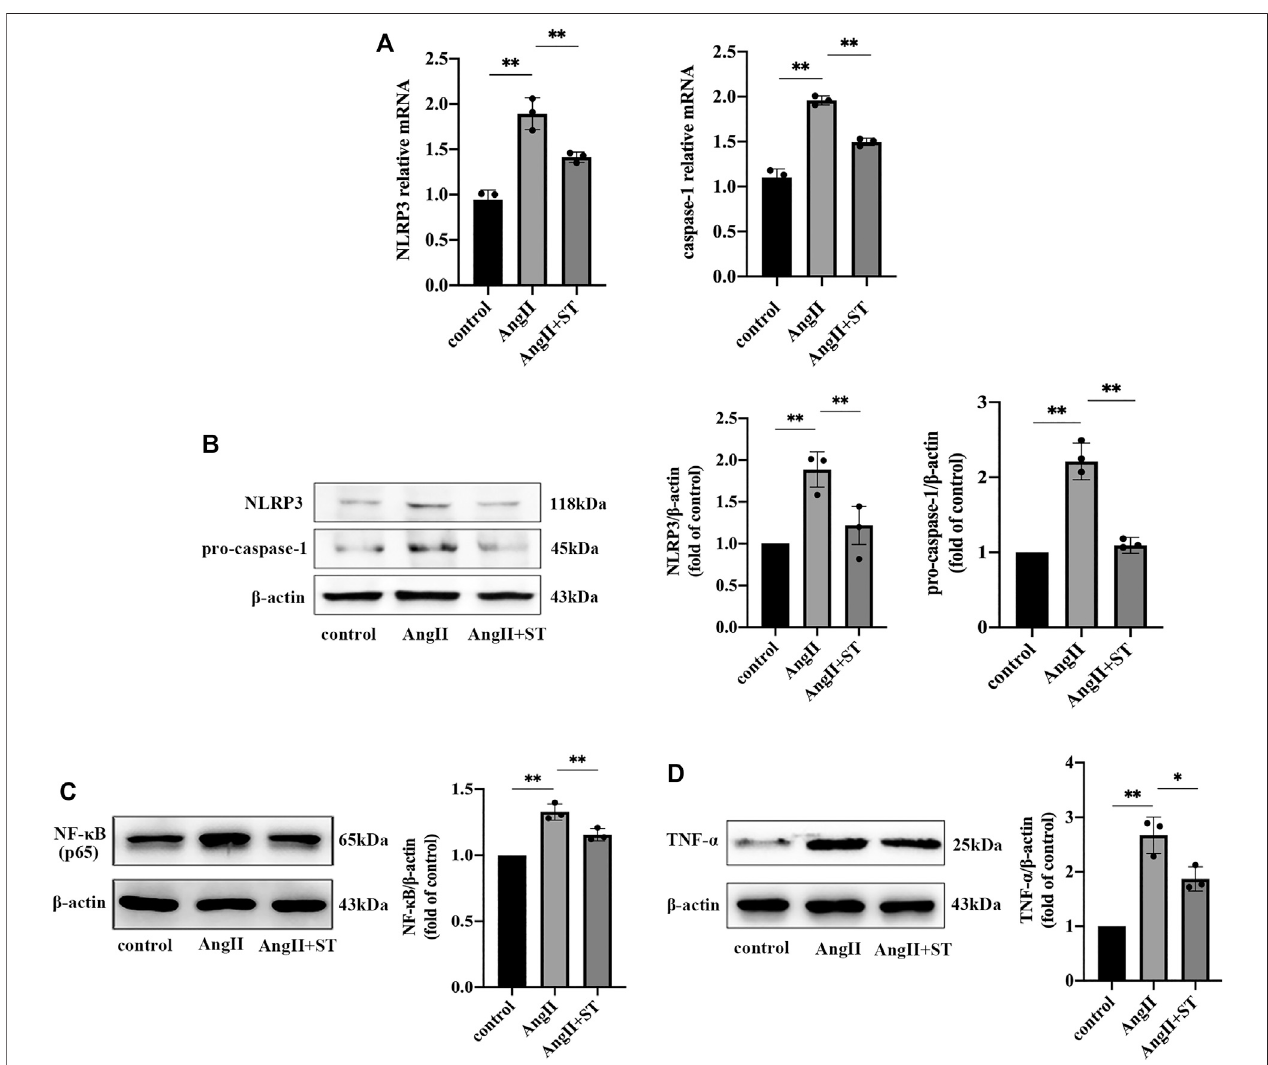
FIGURE5| STinhibited AngII-induced NLRP3in fl ammasomeactivationinHUVECs. (A) PCRanalysisoftheexpression ofNLRP3 andcaspase-1in control, Ang Ⅱ and Ang Ⅱ +ST groups. (B) Western blot analysis of NLRP3 and pro-caspase-1 in above three groups. The data were presented in fold of control. (C) Western blot analysis of NF- κ B (p65) in above three groups. The data were presented in fold of control. (D) Western blot analysis of TNF- α in above three groups. The data were presented in fold of control. All data were shown as mean ± SD (error bars) from three independent biological repeats experiments, each of which included three technical repeats. * p < 0.05; ** p <